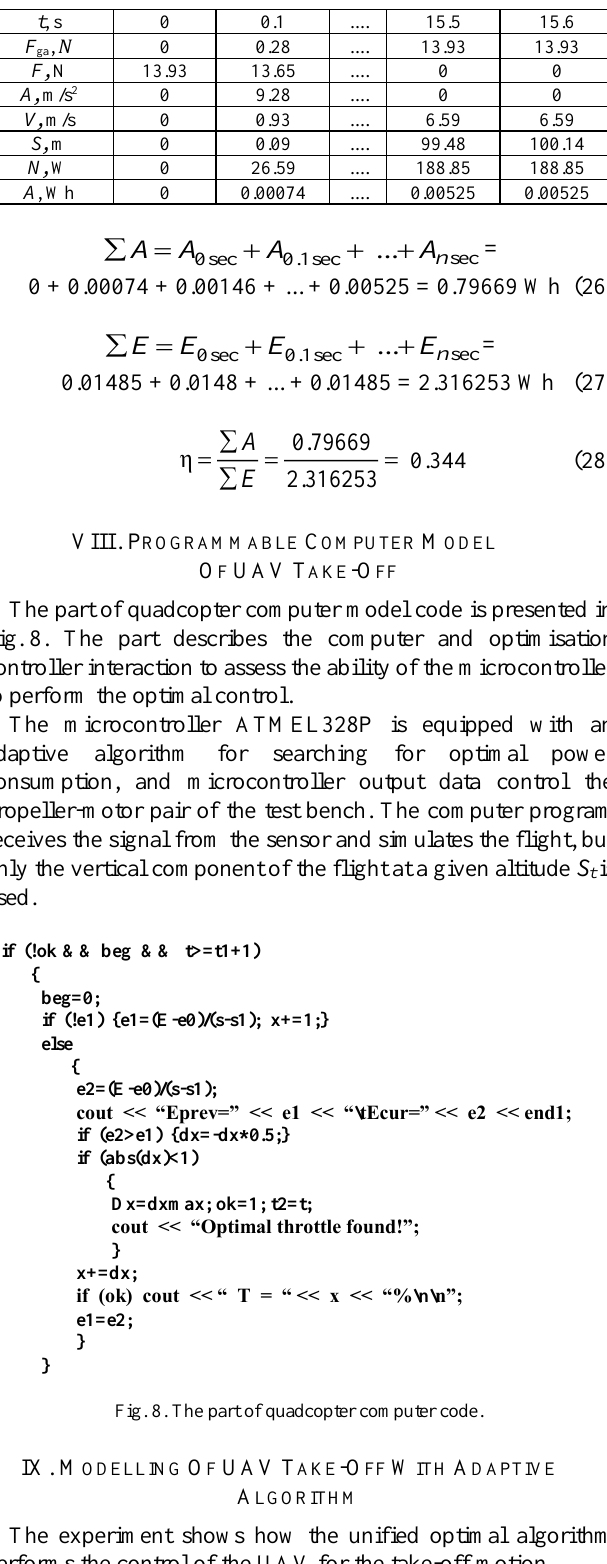
TABLE II T HE P ART OF 100 M V ERTICAL I NTEGRATED T AKE - OFF